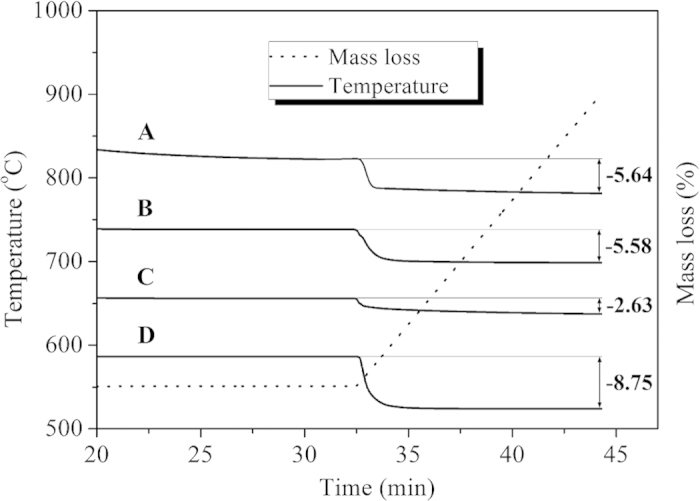
TGA profiles of (A) Ni-PTA/Al2O3 grain after use for 10 h, (B) Ni-PTA/Al2O3 powder after use for 10 h, (C) synthetic Ni-PTA/Al2O3 catalyst after use for 10 h and (D) 70 h. Reaction conditions: 360 °C, 3.0 MPa, 0.8 h−1.